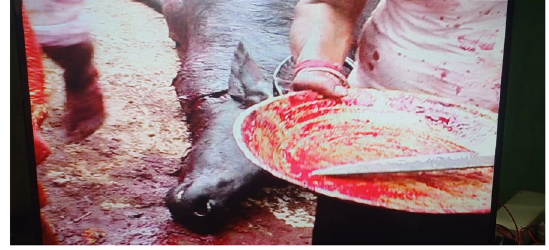
Fig. 10 Butchering a He-Buffalo by cutting the nerve in its neck during the